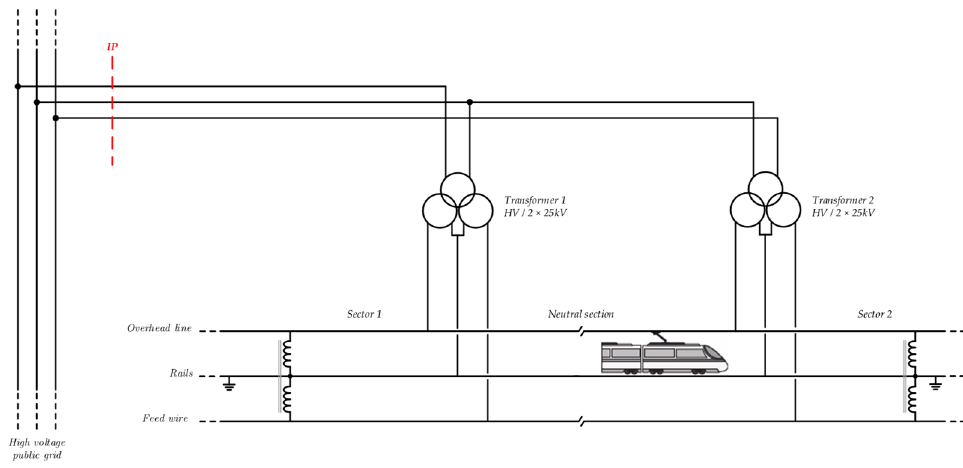
Figure 2. High-speed line substation with two transformers in “V-Connection”.